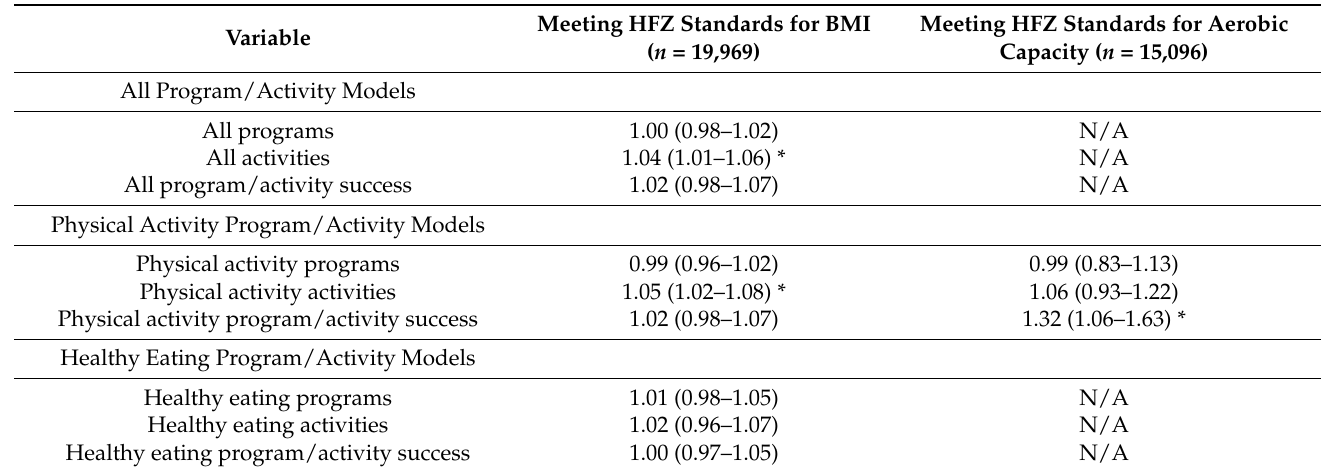
Table 5. Main effects model results (OR (95%